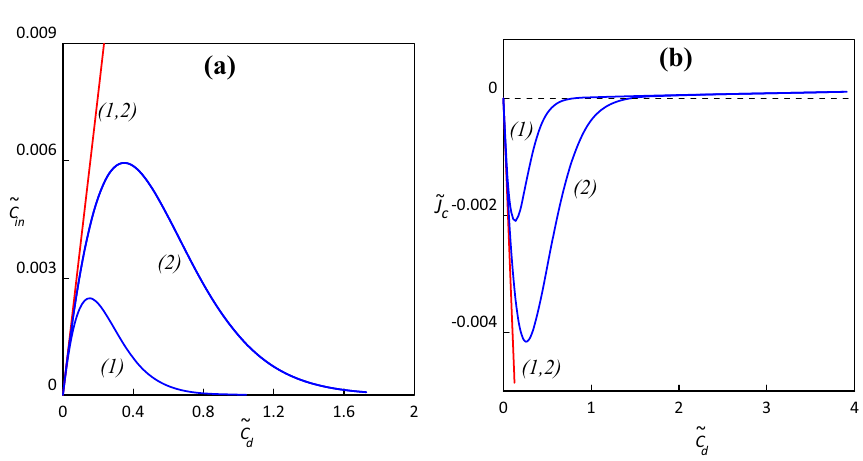
˜ J c ( b ) on the draw concentration = 0.8 , (2) σ = 0.9 .